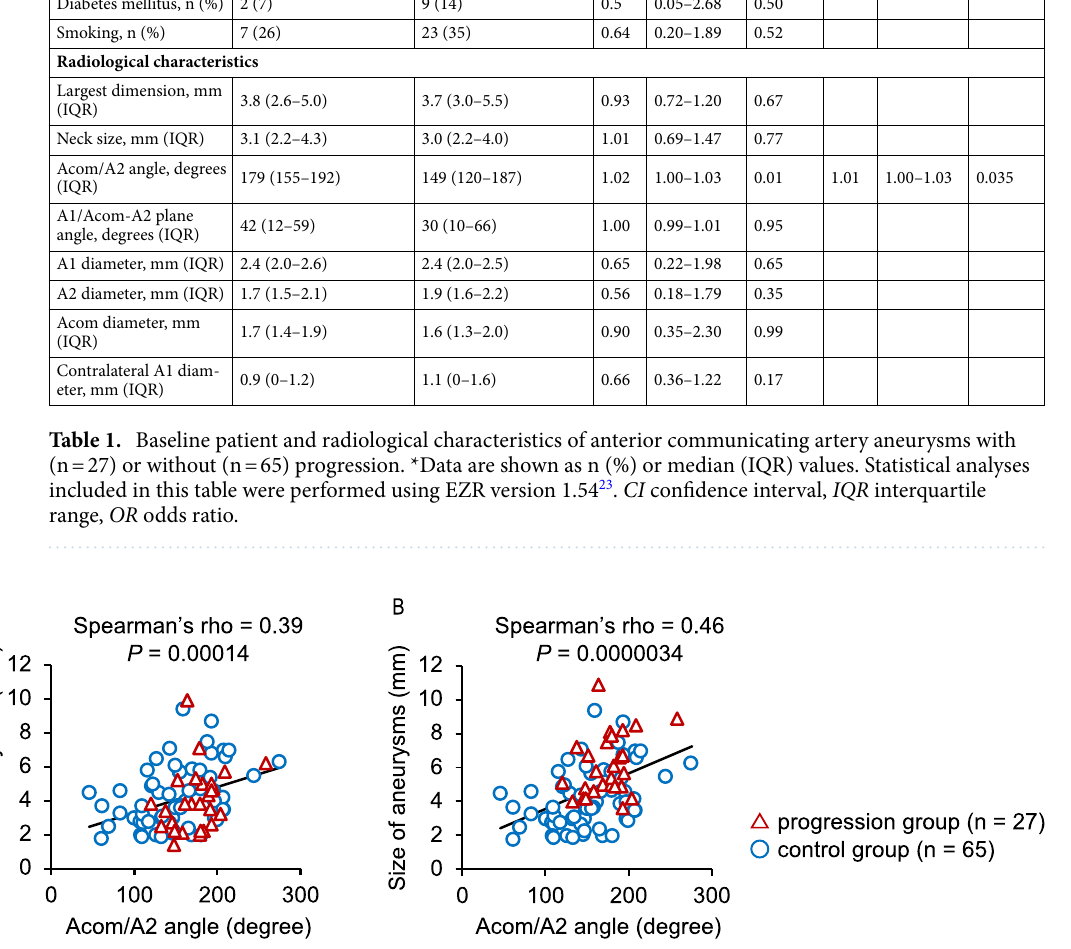
Figure 5. Scatter diagrams with a linear regression line showing the correlation between the largest dimension of anterior communicating artery (Acom) aneurysms and the angle formed between the Acom and the A2 segment of the ACA (Acom/A2 angle). Spearman’s correlation analysis was performed at each time point before ( A ) and after ( B )